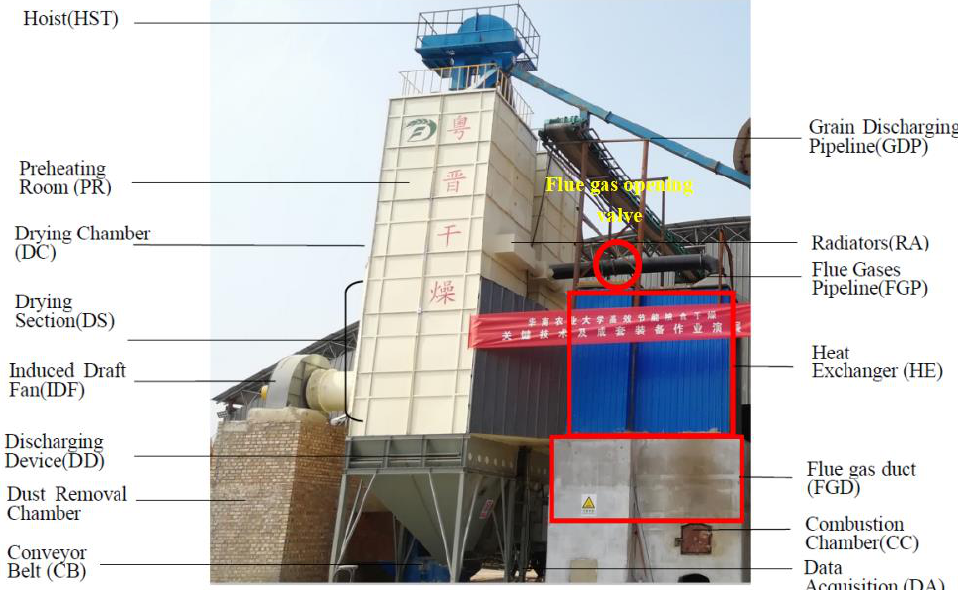
Figure 1. The scene graph of the drying system. Table 1. The details of the experimental